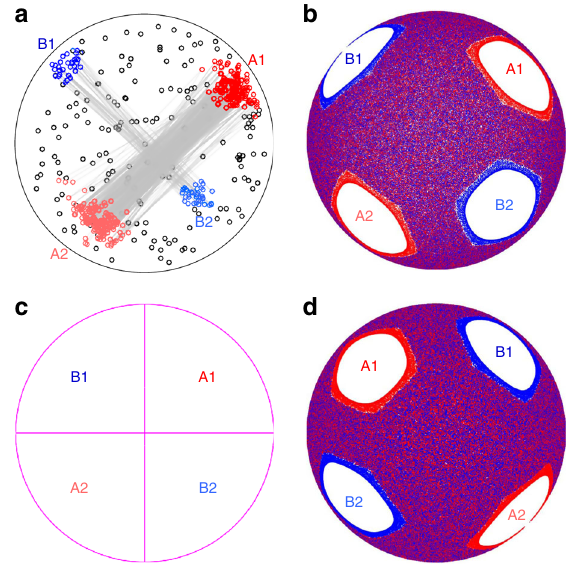
Fig. 3 Period-2 non-mixing regions under the (90°, 90°) protocol. a Tracer particle in a 500-iteration experiment appears in period-2 regions A1-A2 (red circles) for 263 iterations (mean 38 iterations per instance) and B1-B2 (blue circles) for 46 iterations (mean 12 iterations per instance), stroboscopic paths indicated by gray lines. b In the FL model, two sets of period-2 regions (A1-A2 and B1-B2) exist. c The PWI model undergoes trivial period-2 rearrangement of the entire domain. d Interchange of non- mixing A and B regions in the FL model at 500 plus one-half-iteration illustrates the generic (i.e., protocol independent) half-period offset relationship between A and B non-mixing regions into mixing regions by virtue of stretching in the FL 27 , a point we return to below.